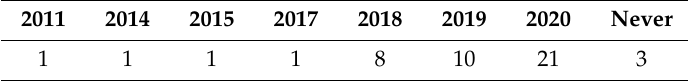
Table 5. Year of the last update on the press